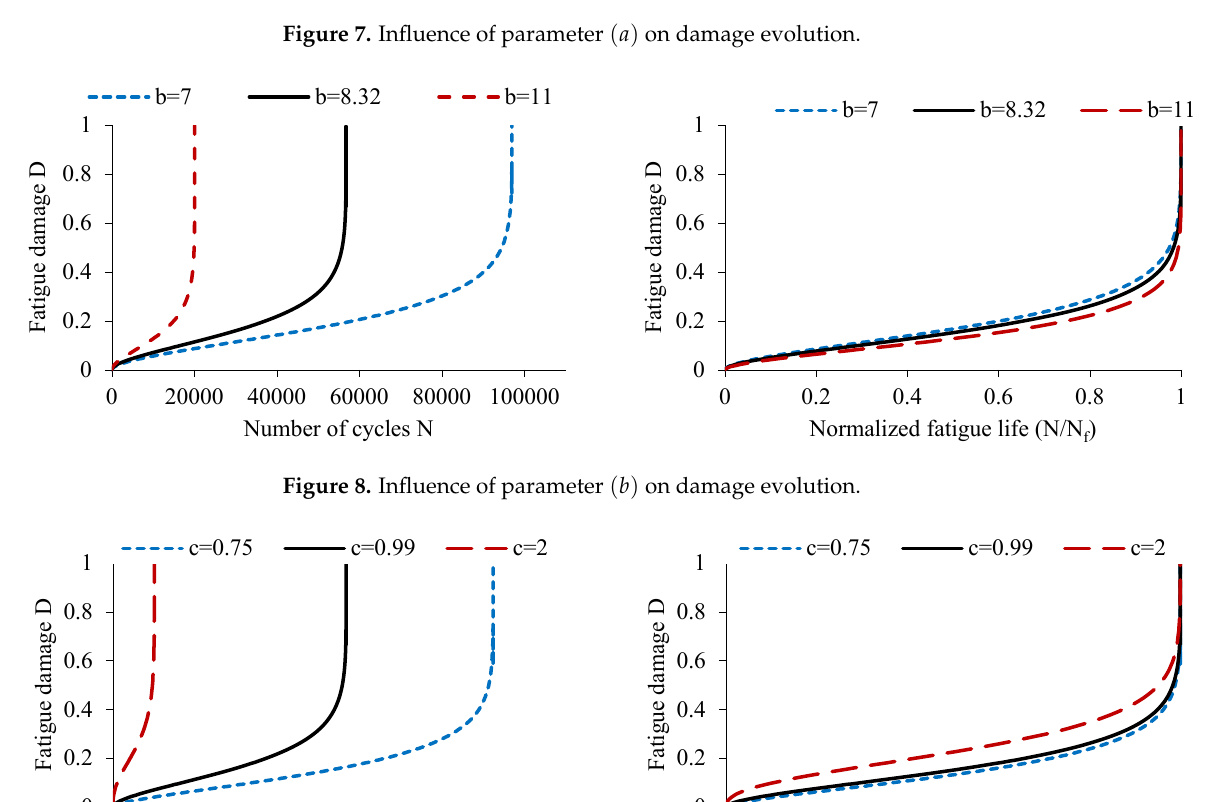
Figure 8 demonstrates that the parameter ( ) b has a notable impact on the kinetics